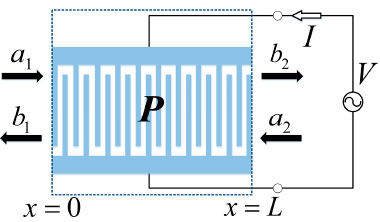
Figure 11. The schematic of the P -matrix in the IDT section.